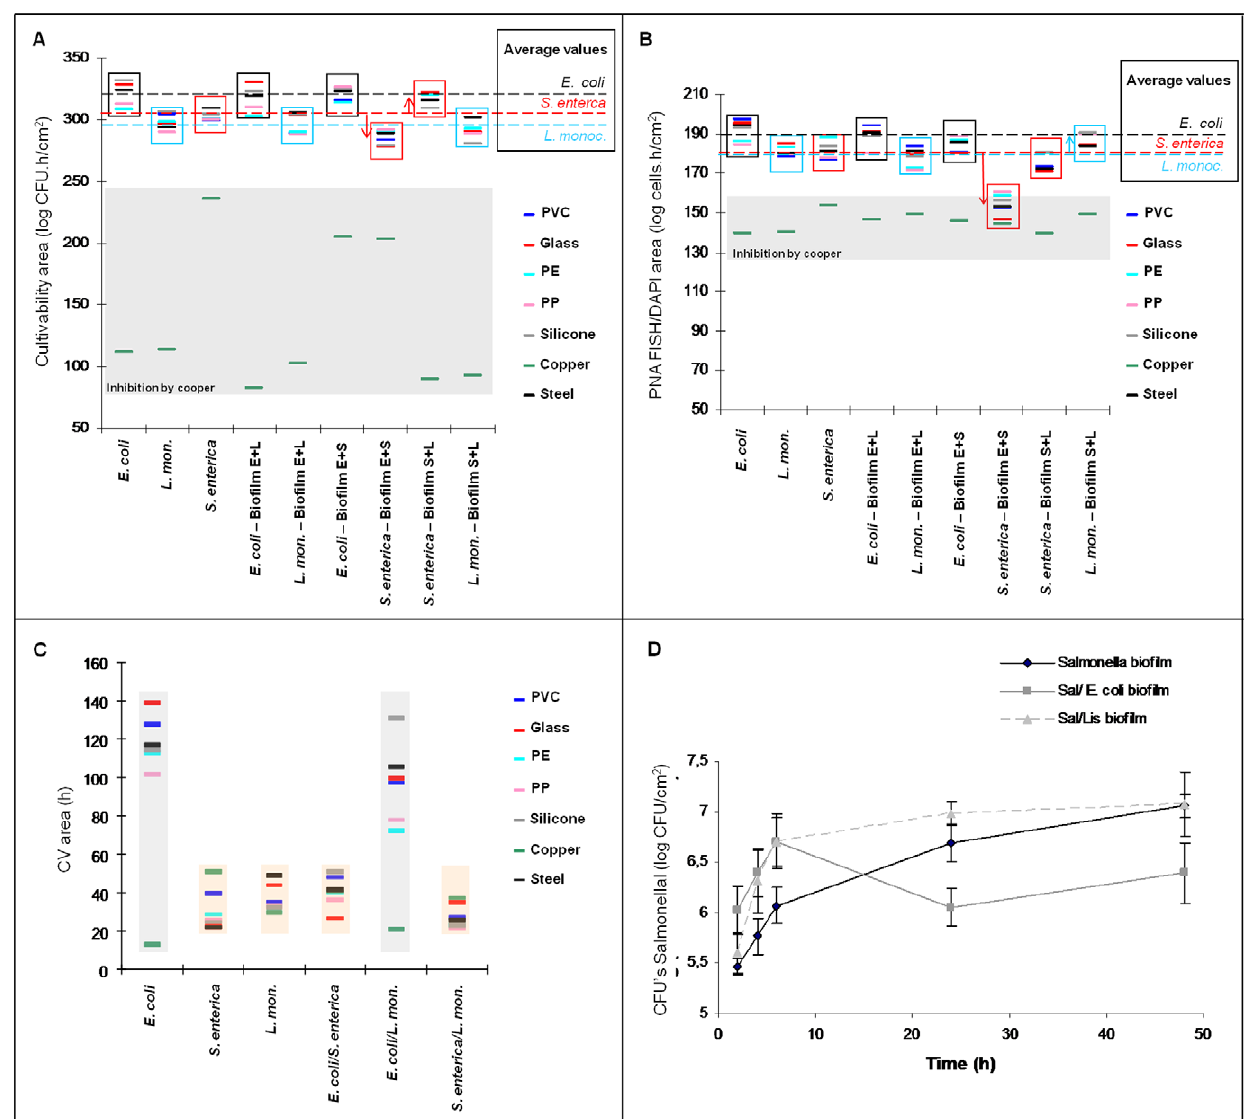
Figure 4. Biofilm formation profiles for each species on single- and dual-species biofilms. Cultivability (A) and PNA FISH/DAPI (B) areas showing the populations variations when co-cultured with a different species. (C) CV areas showing two typical CV profiles, the E. coli profile (at grey) suggesting a high production of exopolymers, and the L. monocytogenes and S. enterica profile (at pink) showing a reduced ability to produce exoplimers. The CV profile for E. coli/S. enterica biofilm suggests that Salmonella affected the E. coli ability to produce exopolymers.